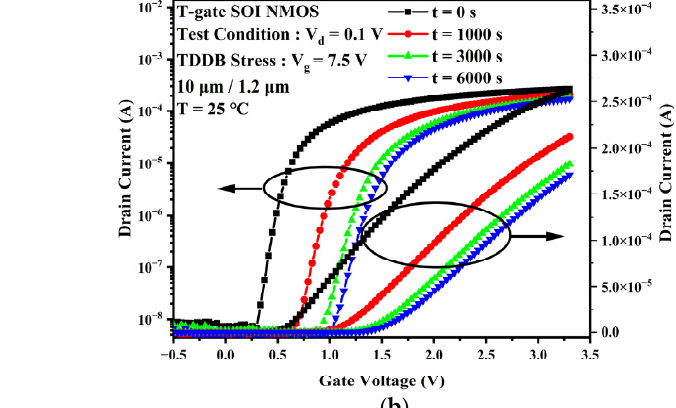
Figure 2. Degradation of the transfer characteristic curve of the device when the TDDB stress is applied ( a ) Vg = 7 V, ( b ) Vg = 7.5 V.